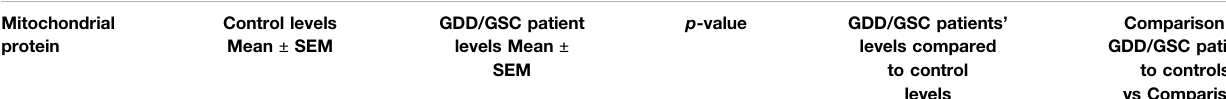
TABLE 2 | CD81-normalized mitochondrial protein levels of GDD/GSC patients and controls. Mitochondrial protein